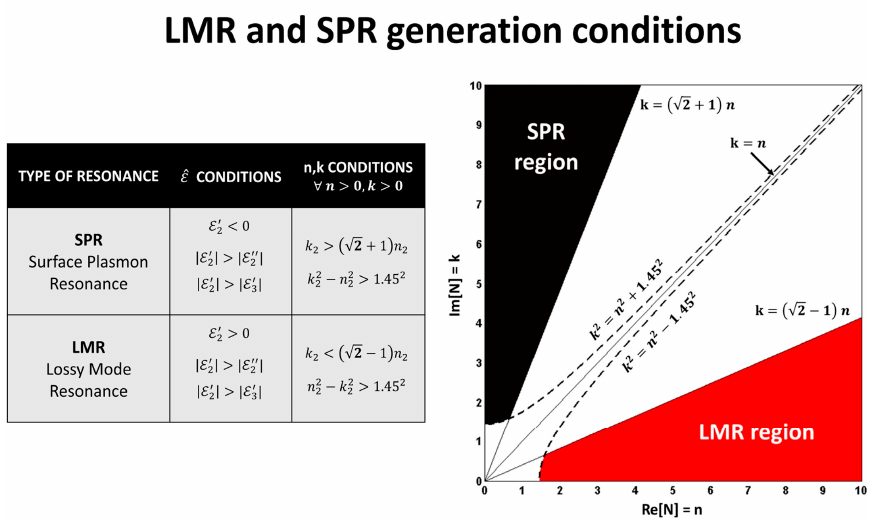
Figure 1. Optical parameters for the generation of surface plasmon resonance (SPR) and lossy mode resonance (LMR). Reprinted from [13] with permission from Elsevier.